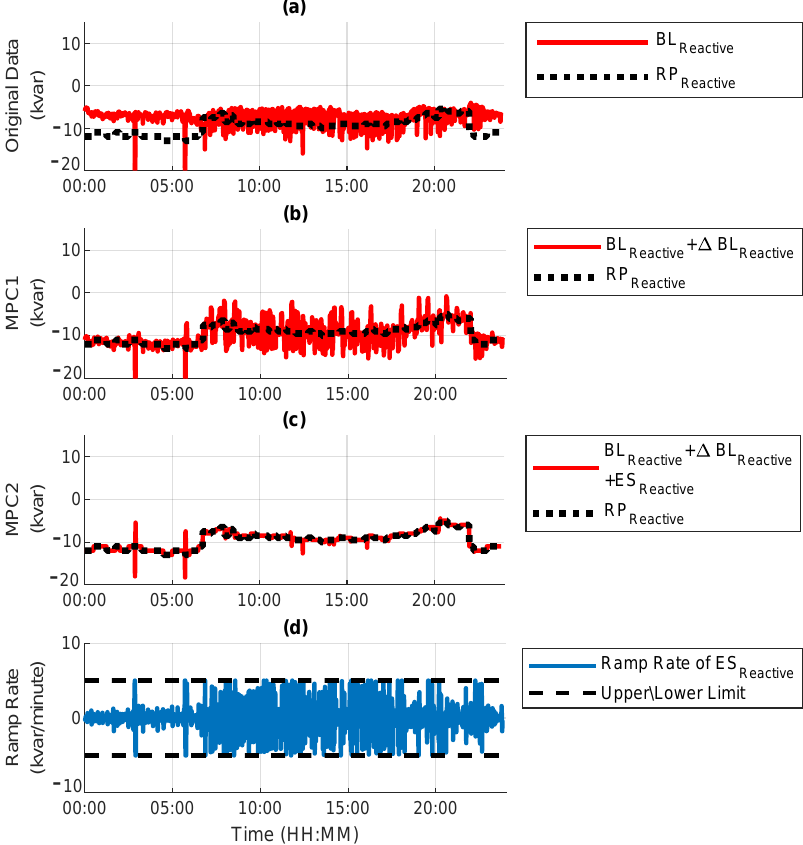
Figure 11. Day 2 reactive power ( a ) original data, ( b ) MPC1 simulation result, ( c ) MPC2 simulation results, and ( d ) ramp rate constraint.